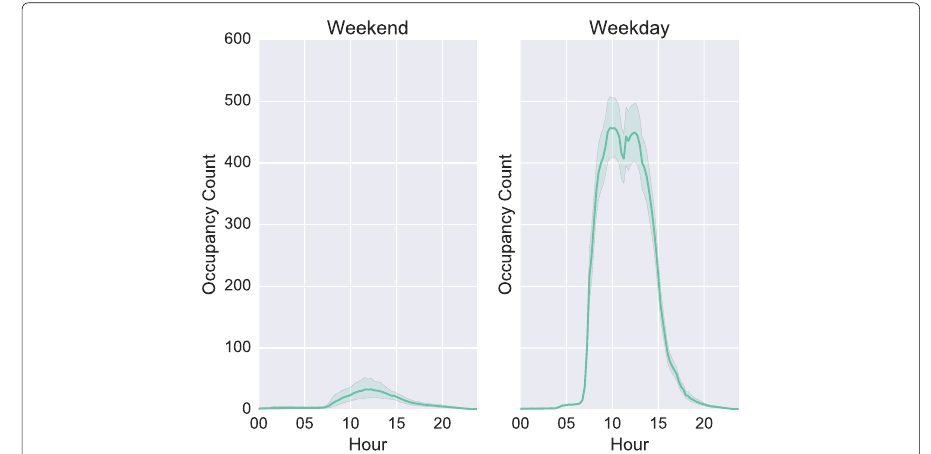
Fig. 4 Occupant pattern on weekends vs